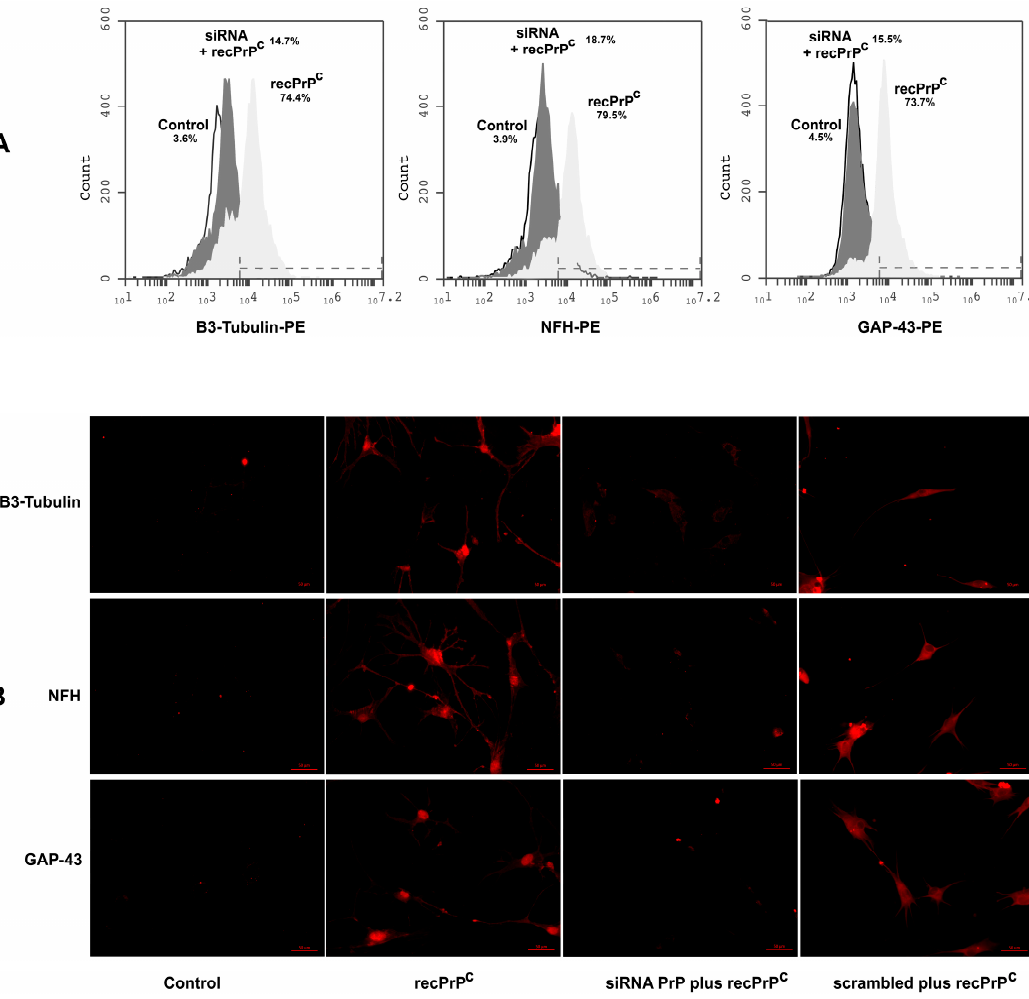
Figure 5. Effect of PrP C silencing on expression of neuronal markers B3-Tubulin, NFH and GAP-43. hDPSCs, stimulated with 0.5 µg/mL of recPrP C for 14 days in the presence or in the absence of pre-treatment with siRNA PrP or scrambled siRNA for 72 h, were analyzed by flow cytometry or immunofluorescence analysis using anti-B3-Tubulin, anti-NFH and anti-GAP-43. ( A ) Flow Cytometry. Histograms represent log fluorescence vs. cell number, gated on cell population of a side scatter / forward scatter (SS / FS) histogram. Cell number is indicated on the y-axis, and fluorescence intensity is represented on the x-axis. Each panel was compared with the corresponding secondary antibody as a negative control. A representative experiment among 3 is shown. ( B ) Immunofluorescence